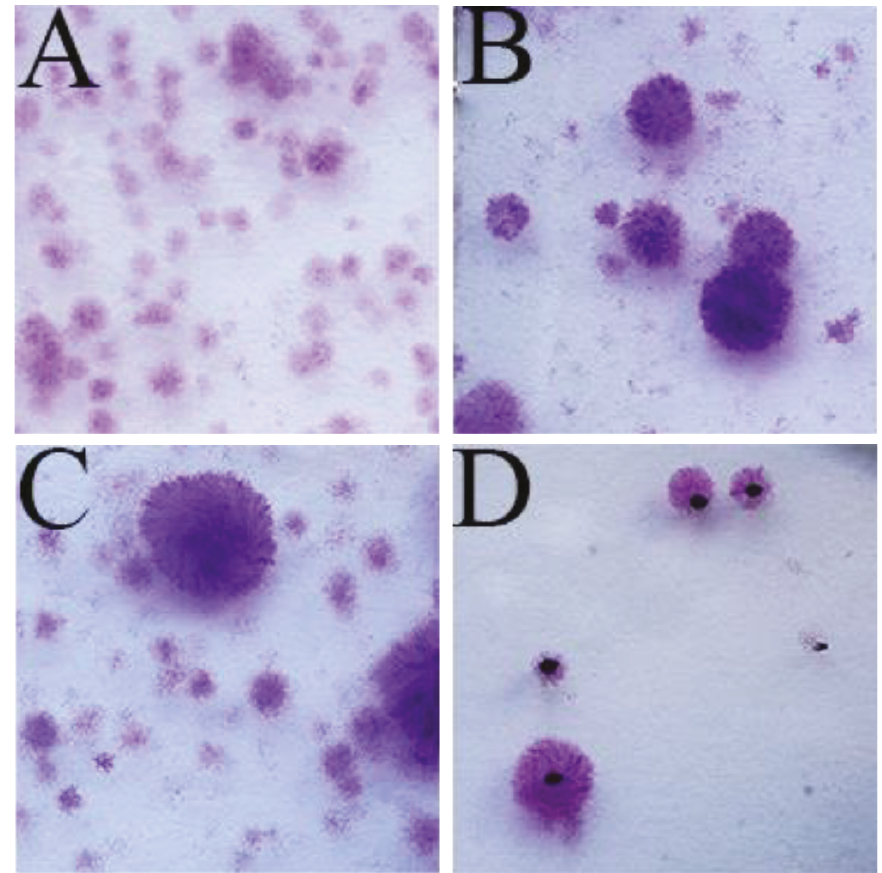
Figure 1: Part of the colonizing forming unit assay made by the crystal violet methanol after seeding SVF cells in T75 fl asks. (A) Seeding of 1 · 10 5 SVF cells from sample 1 for 7 days. (B) Seeding of 1 · 10 4 SVF cells from sample 2 for 12 days. (C) Seeding of 1 · 10 4 SVF cells from sample 3 for 12 days. (D) Seeding of 1 · 10 3 SVF cells from sample 2 for 12 days. Low density of CFU is seen, and black dots form